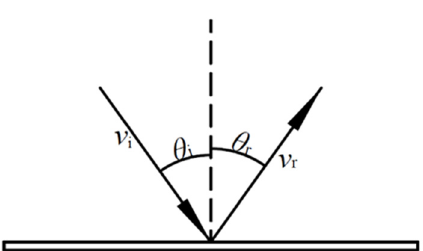
Figure 4. Definition of velocity and angle of coal ash particles impact the stainless steel surface.